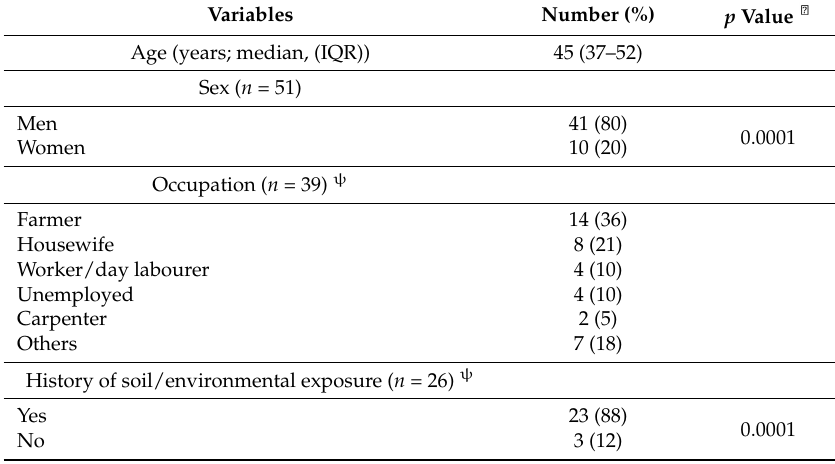
Table 2. Baseline demographic characteristics of the culture-confirmed